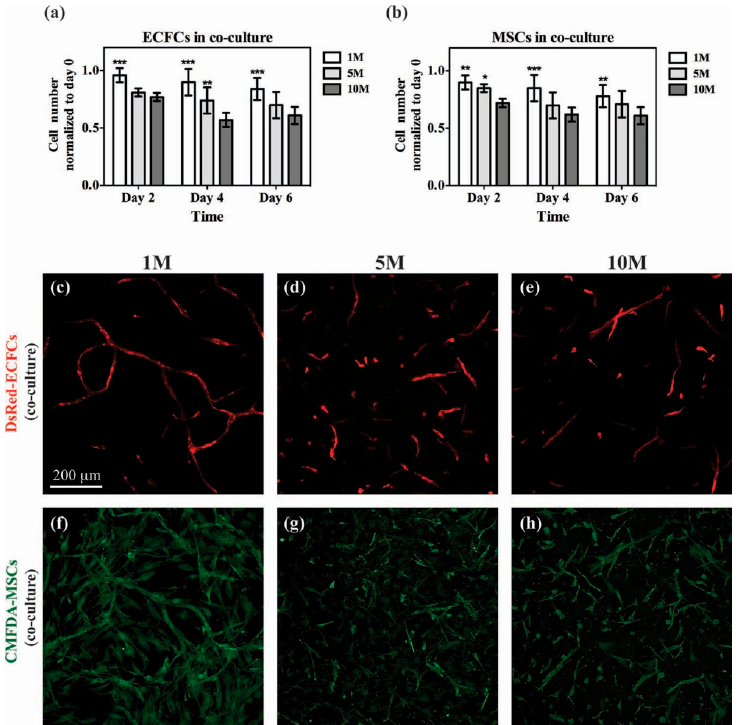
Figure 5. Co-culture of vascular cells in GelMA. Constructs containing both DsRed-ECFCs and CMFDA-labeled MSCs were cultured for 2, 4 and 6 d using GelMA hydrogels with different methacrylation degrees. ( a , b ) Numbers of DsRed-ECFCs ( a ) and CMFDA-MSCs ( b ) were separately counted at each time point under a fluorescence microscope. ( c – h ) Representative confocal microscopy images of DsRed-ECFCs ( c – e ) and CMFDA-MSCs ( f – h ) after day 6 in co-culture for each methacrylation degree. [28]. (Reproduced with permission from Chen Y-C et al. Advanced Functional Materials; published by John Wiley and Sons,